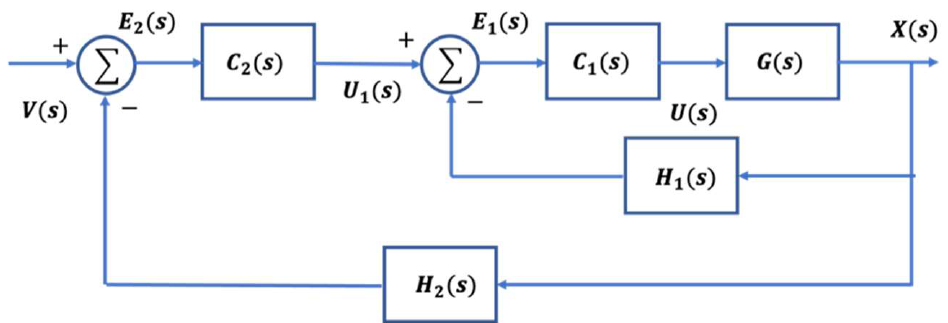
Figure 2. Transform and Control Architecture.